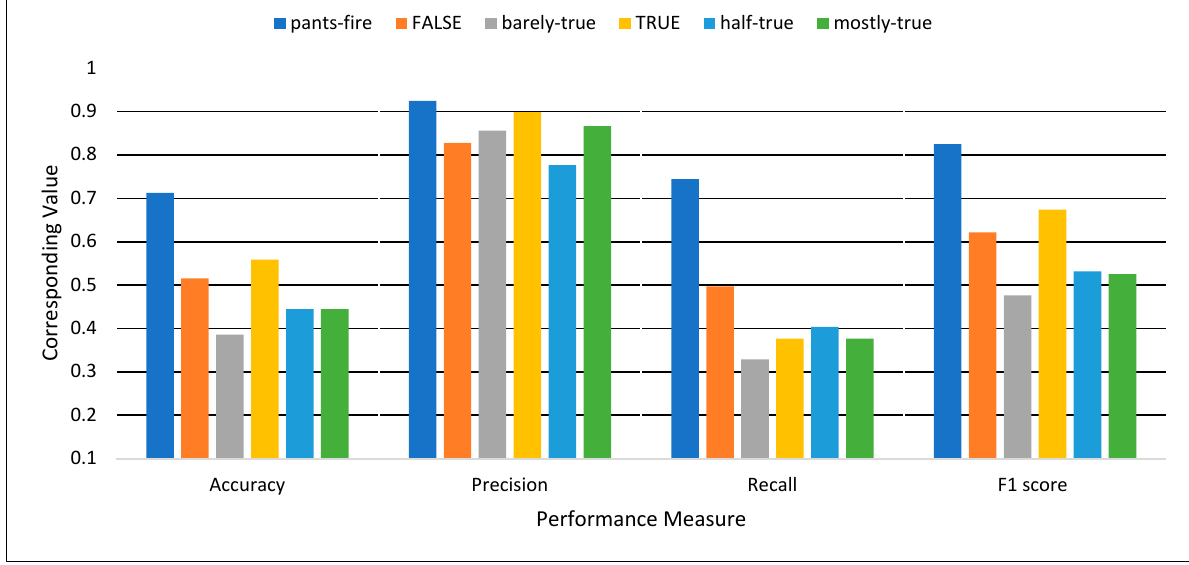
Figure 7. The Performance of the Multi-class Classification (2nd stage).